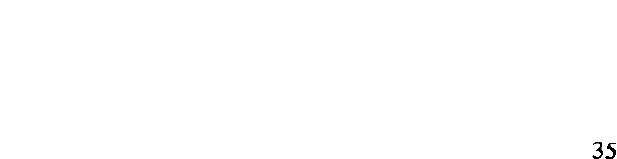
Die Stemaanvangstyd van Apraktiese en Disartriese Sprekers foute eers van mekaar onderskei kan word as die